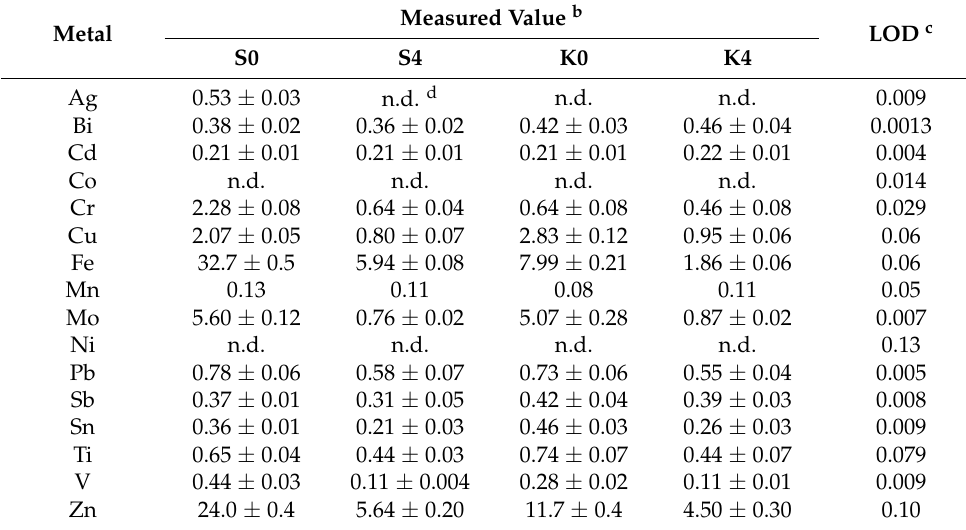
Table 3. Concentrations and limits of detection of metals in seawater ( µ g L − 1 ± σ ; n = 3) a .